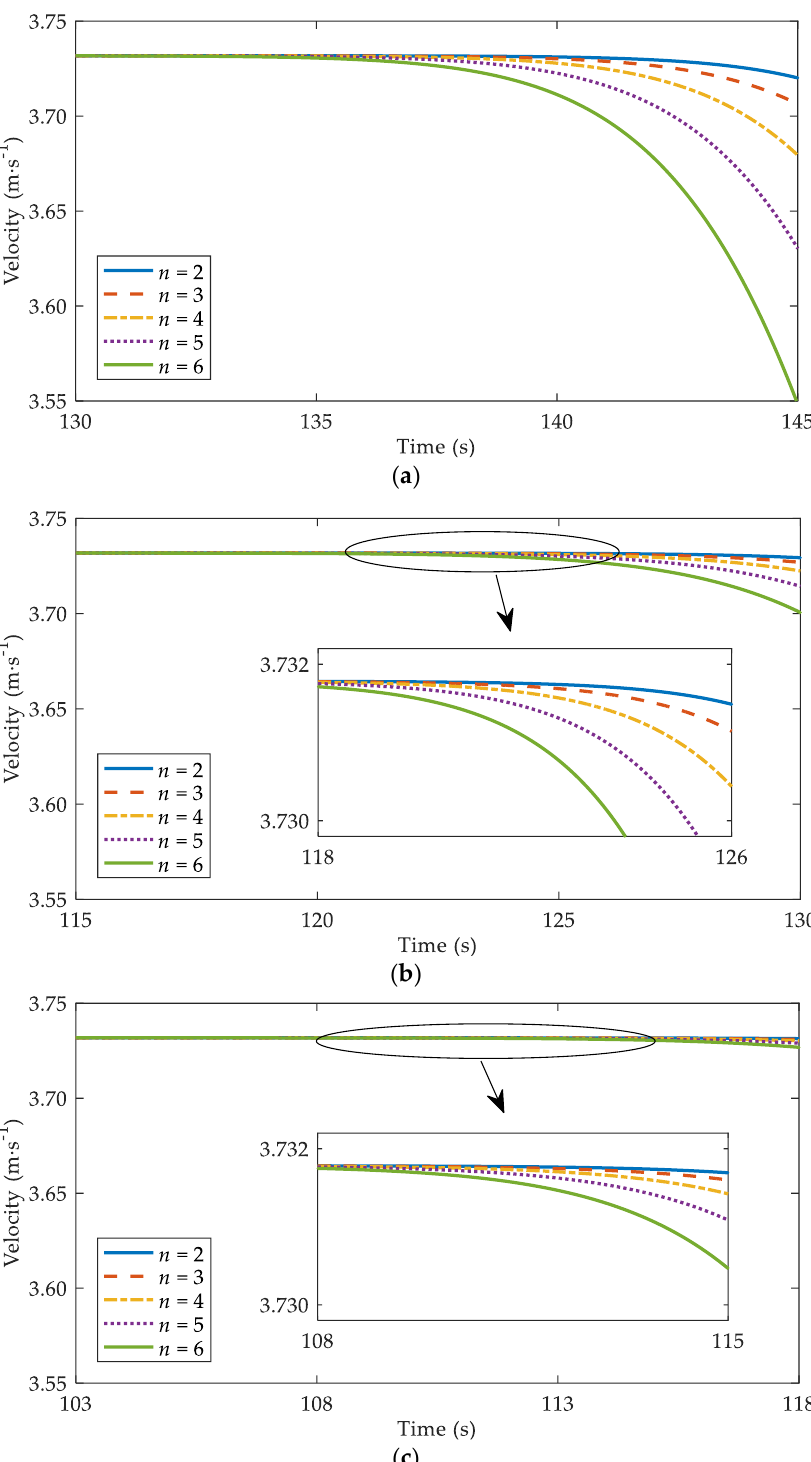
Figure 7. Velocity trajectories for vehicles numbered n = 2, 3, 4, 5, 6 under di ff erent β : ( a ) β = 0; ( b ) β = 0.2; ( c ) β = 0.4, where α = 0.2, T = 1.2